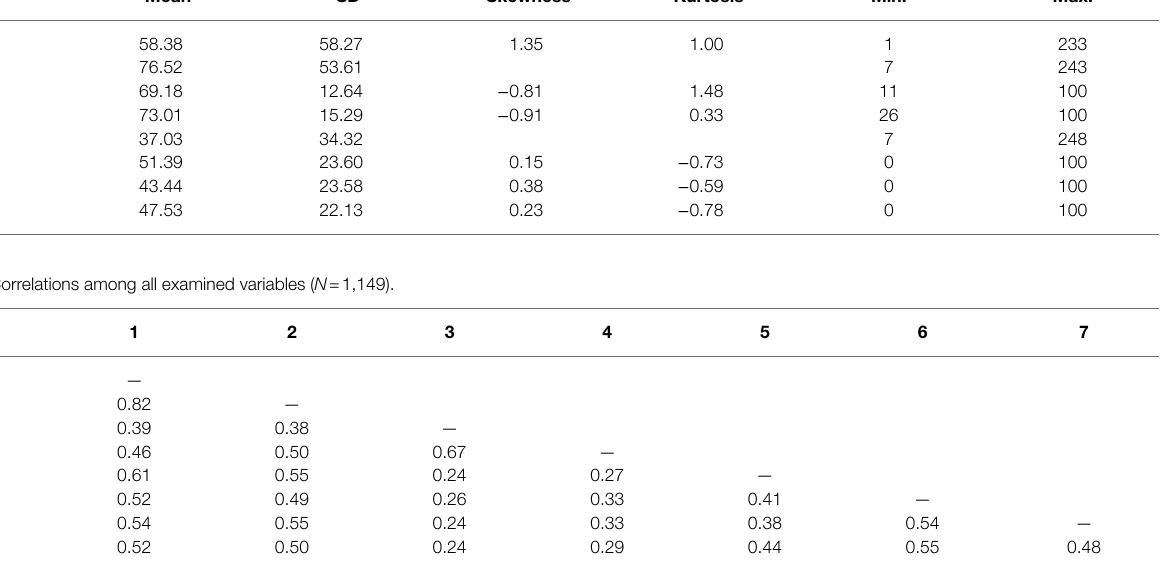
TABLE 2 | Descriptive statistics for DCEC– VS , DCEC–G, and DCEC–RC subtests and subtest subskills ( N = 1,149). Mean SD Skewness Kurtosis Min. Max.